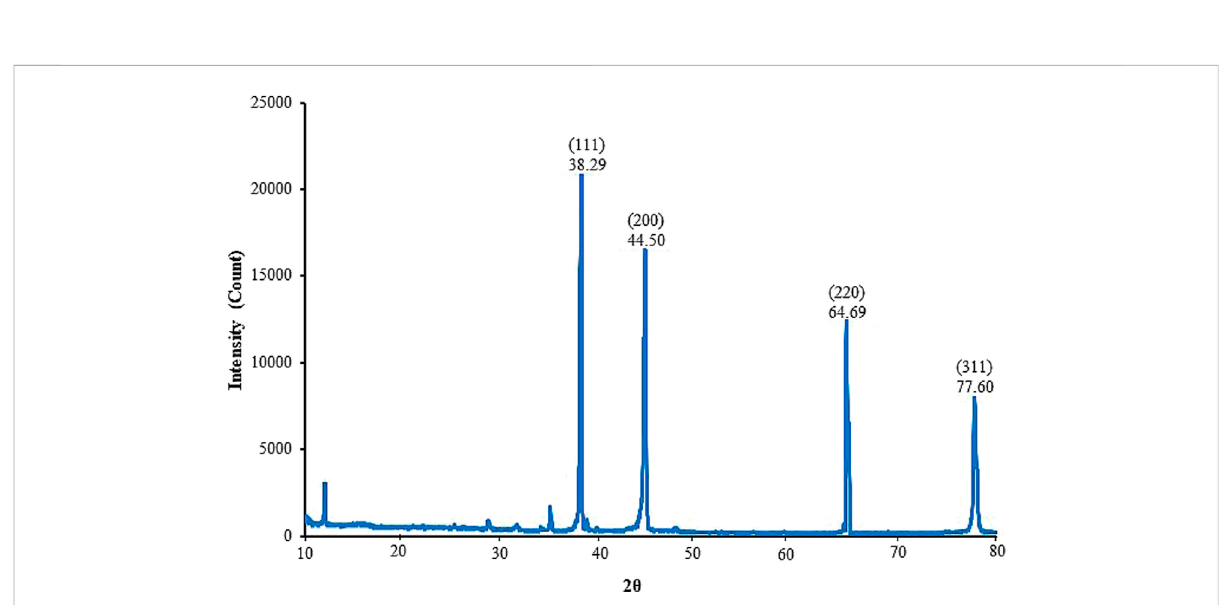
FIGURE 6 X-ray diffractometer patterns for biosynthesized Rn-AgNPs using R. nepalensis leaf extract.